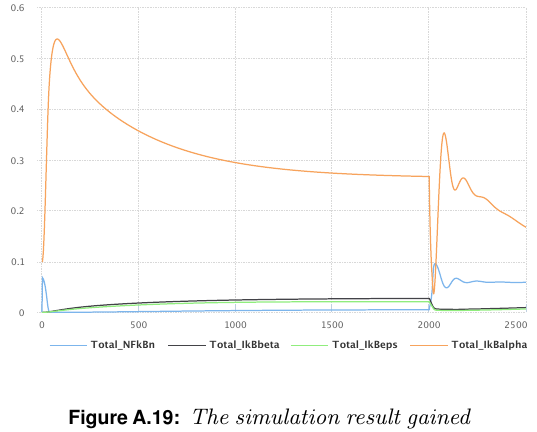
Figure A.20: Simulation with tellurium